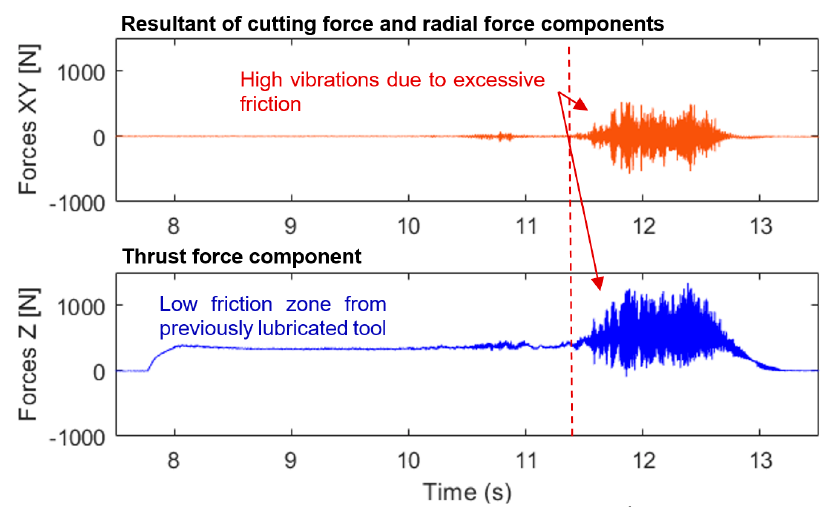
Figure 16. Cutting forces profiles during dry drilling test of Rene 65.